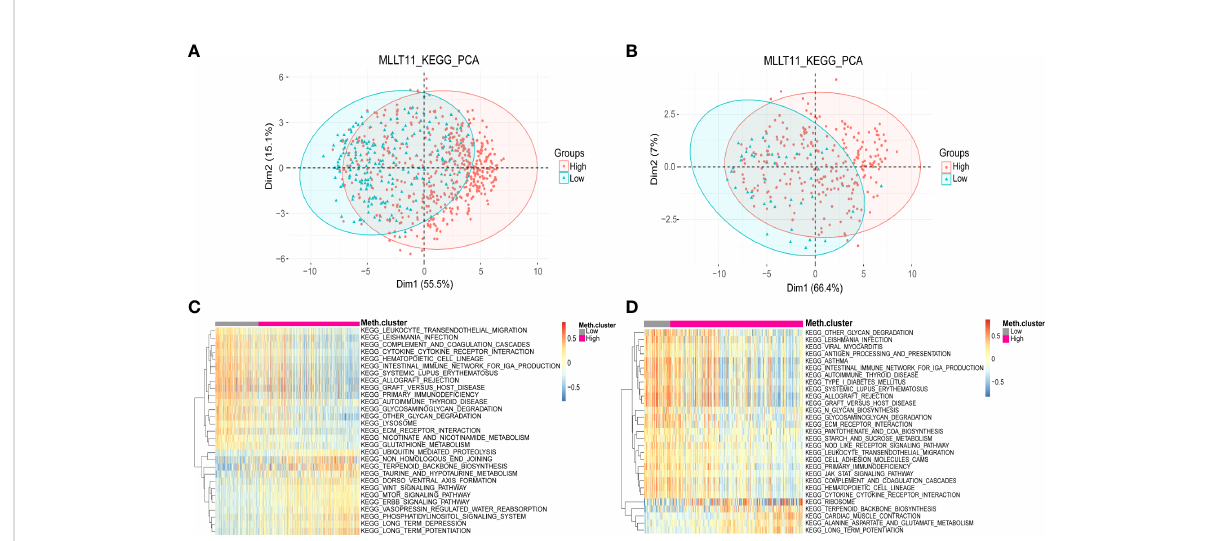
FIGURE 5 Distinct metabolism status in patients with MLLT11 low expression and high expression in glioma. (A, B) PCA between the low-expression and high-expression groups based on total DEGs in TCGA and CGGA dataset. (C, D) KEGG pathway enrichment analyses of DEGs in MLLT11 low- expression and high-expression groups in TCGA and CGGA dataset.